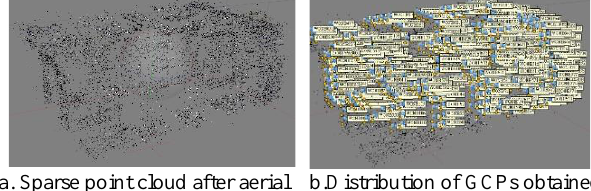
Figure 3. SfM and SCBA results.